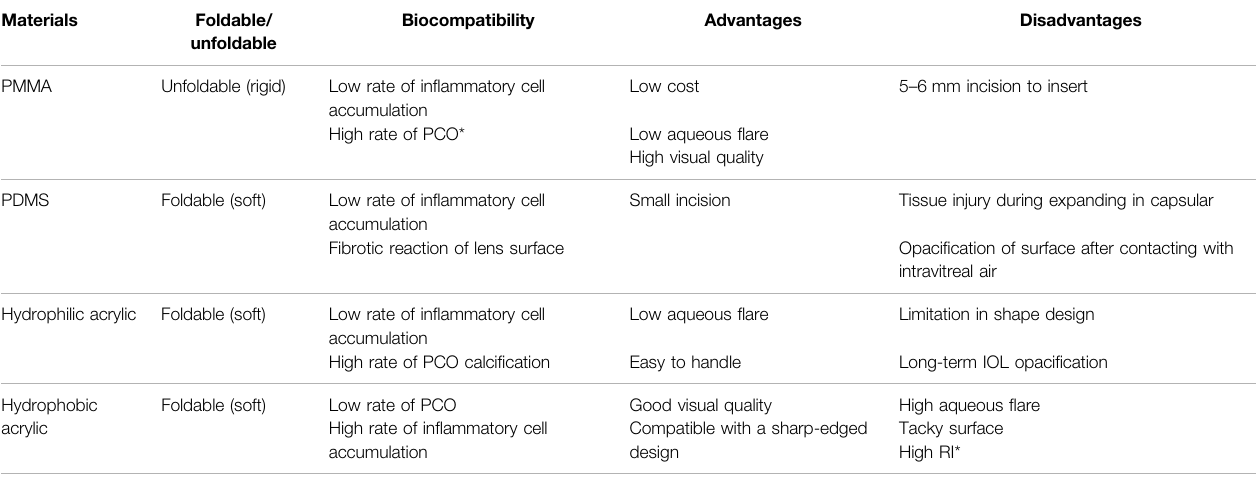
TABLE 1 | Properties of common IOL